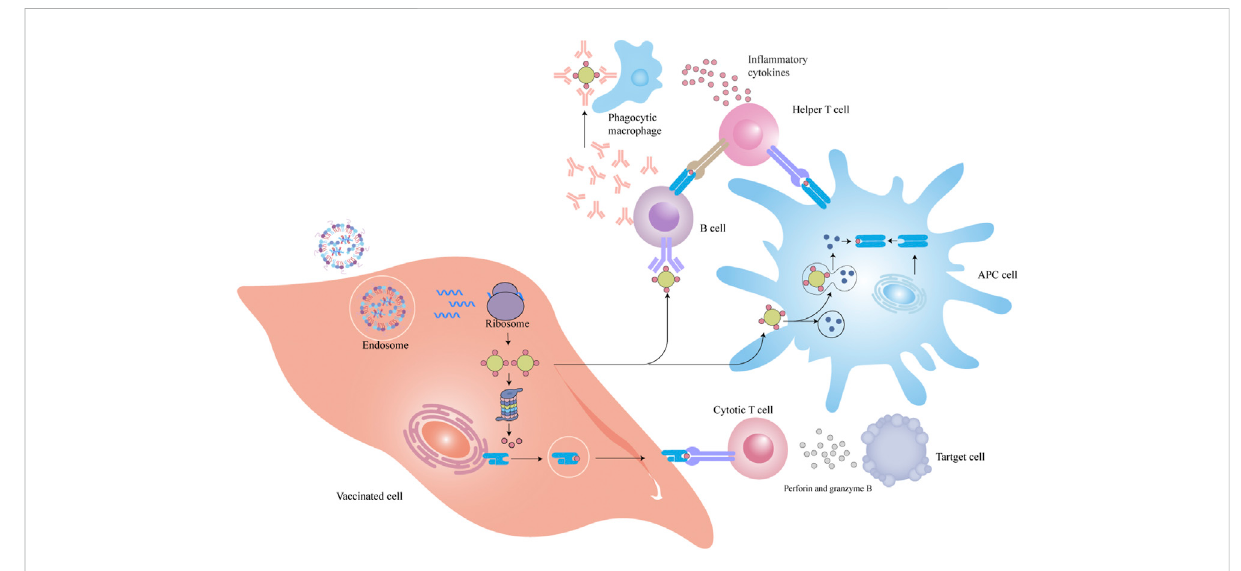
FIGURE 7 LNP-mRNA vaccines immune response